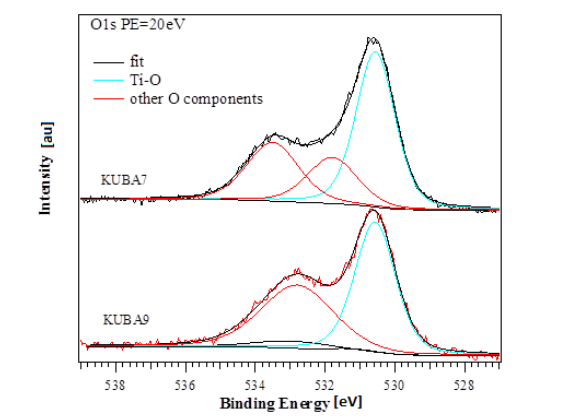
Figure 12. XPS spectrum courses close to O1s line observed for the K7 and K9 samples.